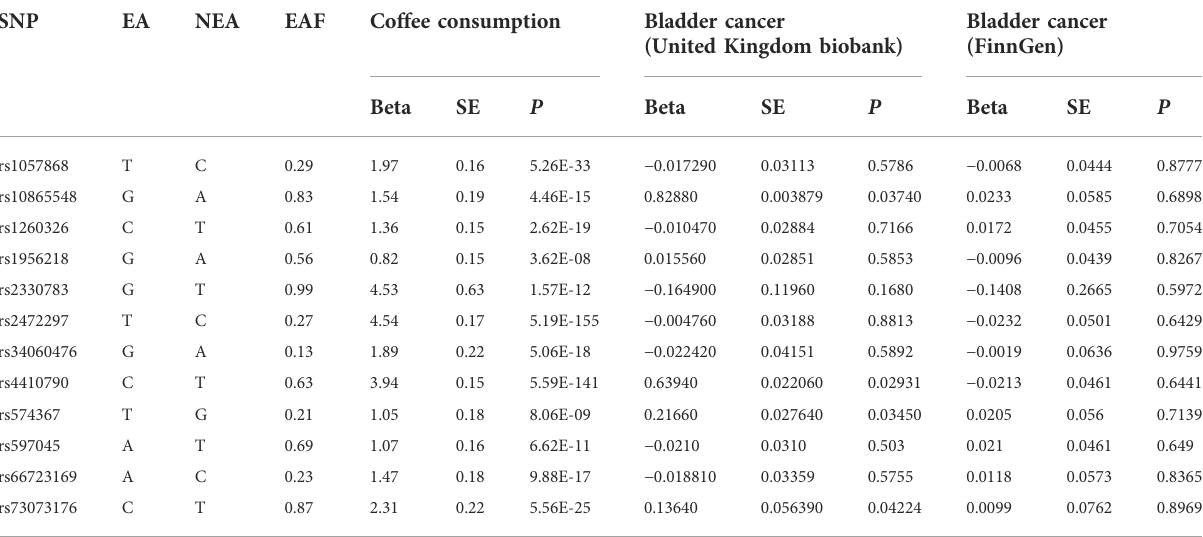
Bladder cancer (United Kingdom